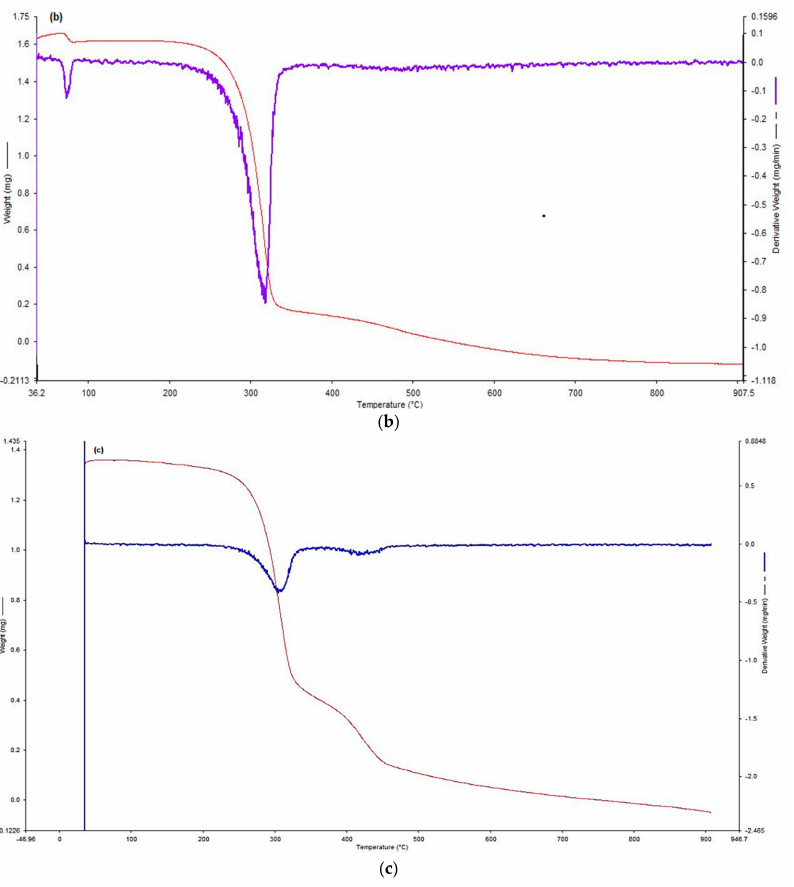
Figure 6. TGA thermograms of ( a ) HCT, ( b ) SMS-PCL blank, and ( c ) HCT-loaded